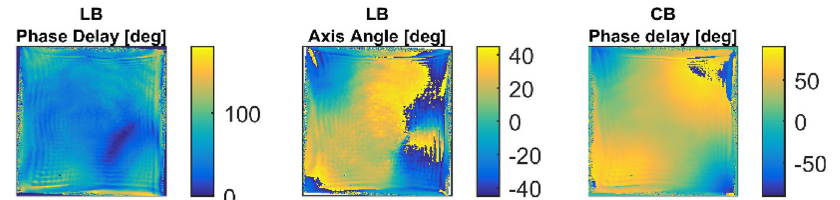
Figure 4. Thermally induced birefringence measured in the laser system which includes also several beam rotations, image-relays and other non-polarization effects. LB Phase Delay the phase delay of the linear